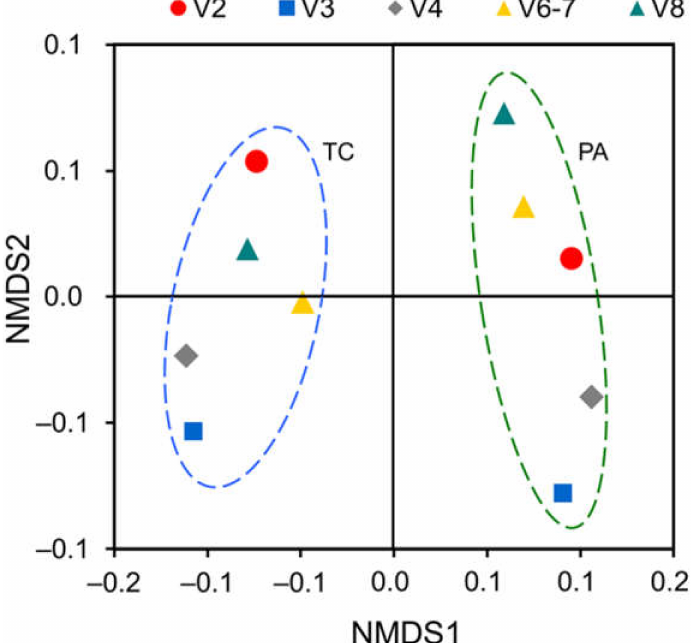
Figure 6. Nonmetric multidimensional scaling (NMDS) analysis of variability among the bacterial OTU data sets generated for the tobacco shoot control (TC) and post-antibiotic treatment (PA) samples using five 16S rRNA gene variable region-specific primer pairs. The analysis was carried out using the Bray–Curtis dissimilarity matrix and the OTU data of five primer pairs for each experimental